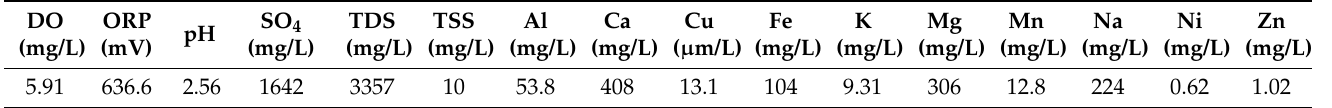
Table 1. Acid mine drainage determinands. DO—Dissolved Oxygen; ORP—Oxygen Reduction Potential.